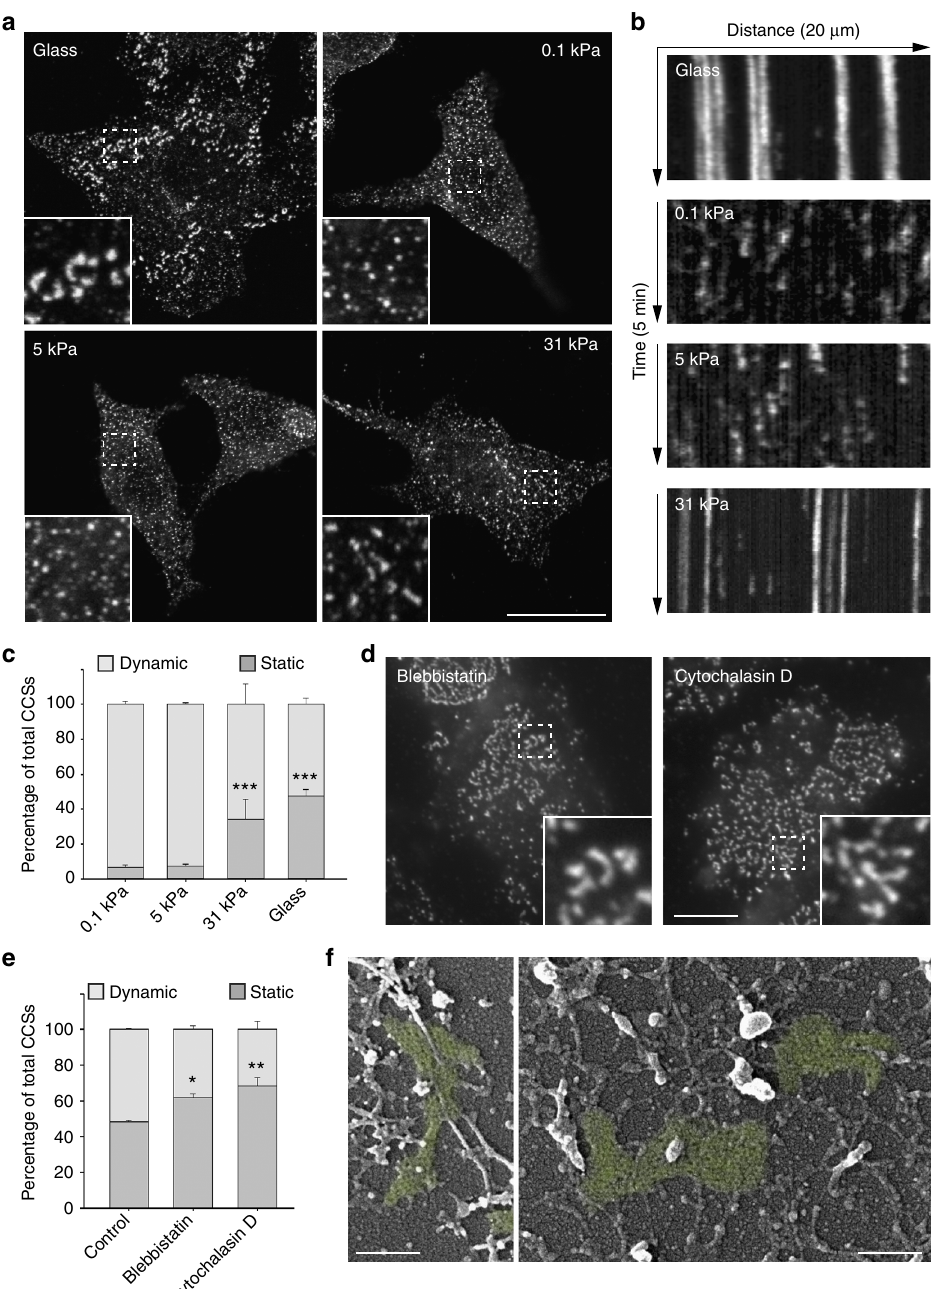
Fig. 1 Clathrin-coated plaques are mechanosensitive structures. a HeLa cells were seeded on collagen-coated glass or polyacrylamide gels of indicated stiffness and fi xed 24 h later before being stained for α -adaptin. Scale bar: 15 µ m. Higher magni fi cations of boxed regions are shown. b Kymographs showing CCS dynamics in genome-edited HeLa cells expressing endogenous GFP-tagged μ 2-adaptin seeded on the indicated collagen-coated substrate and imaged by spinning disk microscopy every 5 s for 5 min. c Quanti fi cation of the dynamics of CCSs observed as in b (*** P < 0.001, as compared to 0.1 kPa condition, one-way analysis of variance — ANOVA. n = 3). d HeLa cells seeded on collagen-coated glass were treated with Blebbistatin or Cytochlalasin D as indicated for 30 min before being fi xed and stained for α -adaptin. Scale bar: 10 µ m. Higher magni fi cations of boxed regions are shown. e Quanti fi cation of the dynamics of CCSs observed as in d (** P < 0.01, * P < 0.05, ANOVA. n = 3). f EM micrographs of unroofed HeLa cells that were cultured on glass and treated for 30 min with blebbistatin before being fi xed and processed. Clathrin-coated plaques are highlighted in green. Scale bar: 200 nm. All results